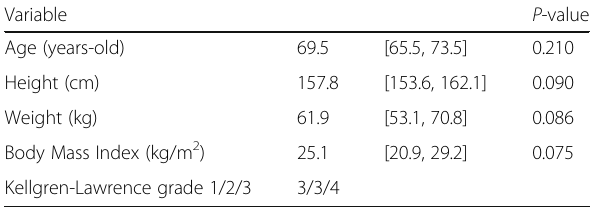
Table 1 Characteristics of the participants Variable